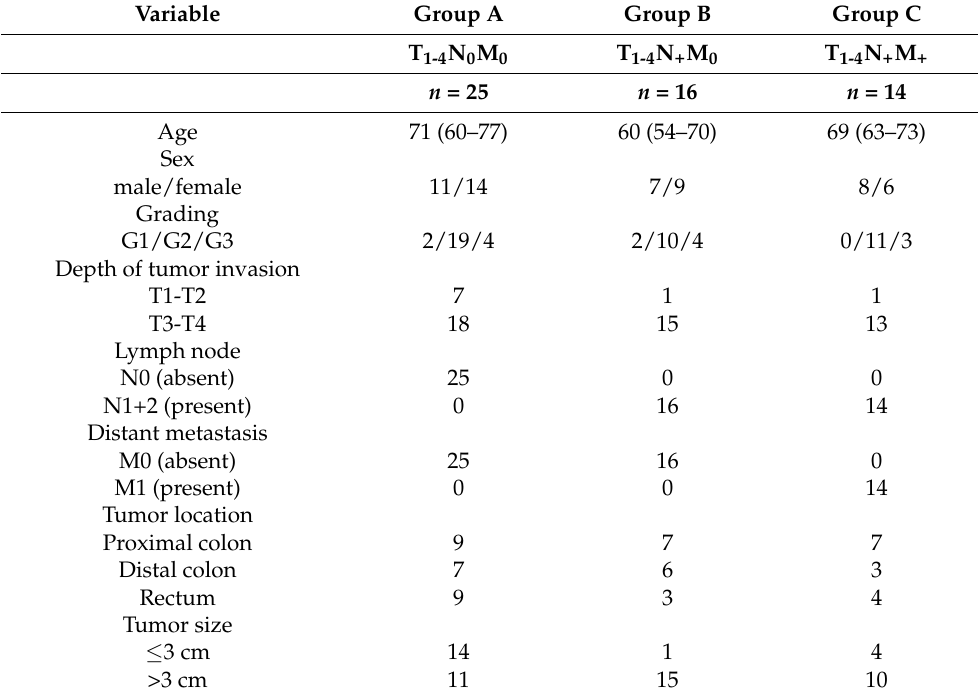
Table 1. Colorectal cancer patient demographical and clinical data. Age is presented as the median with 25th and 75th